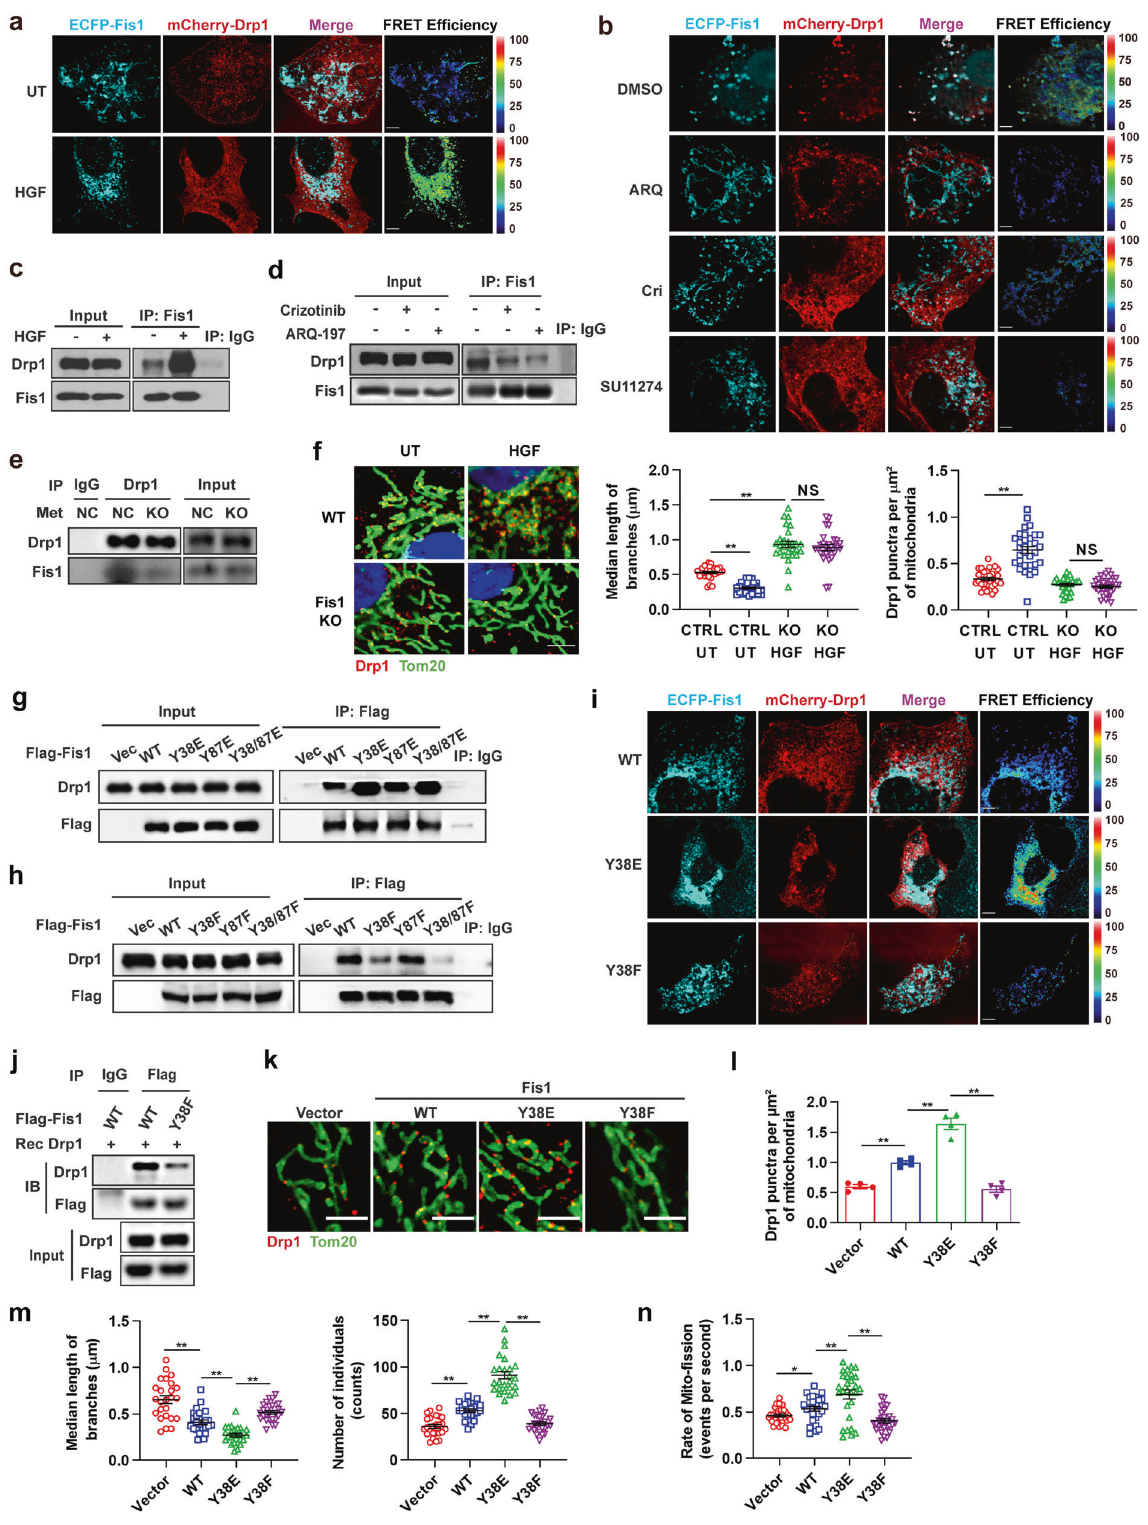
much more negative prognoses (recurrence, metastasis, or death) (Logrank p < 0.01; Fig. 7c – f). High expression of HGF or p-Fis1 (Y38) was correlated with shorter tumor-free interval; the median tumor- free interval in patients with low HGF expression was 59.17 months, while in patients with high HGF expression, it was only 49.19